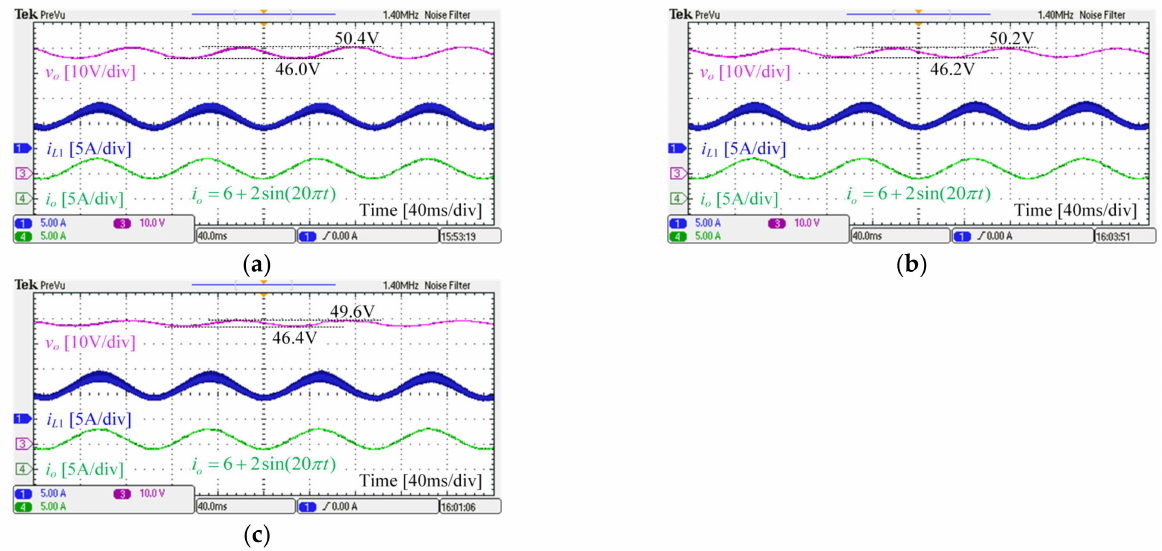
Figure 12. Experimental results of different controllers under sinusoidal load disturbance: ( a ) cas- caded PI controller; ( b ) MPC-ESO controller; ( c ) MPC-GPIO